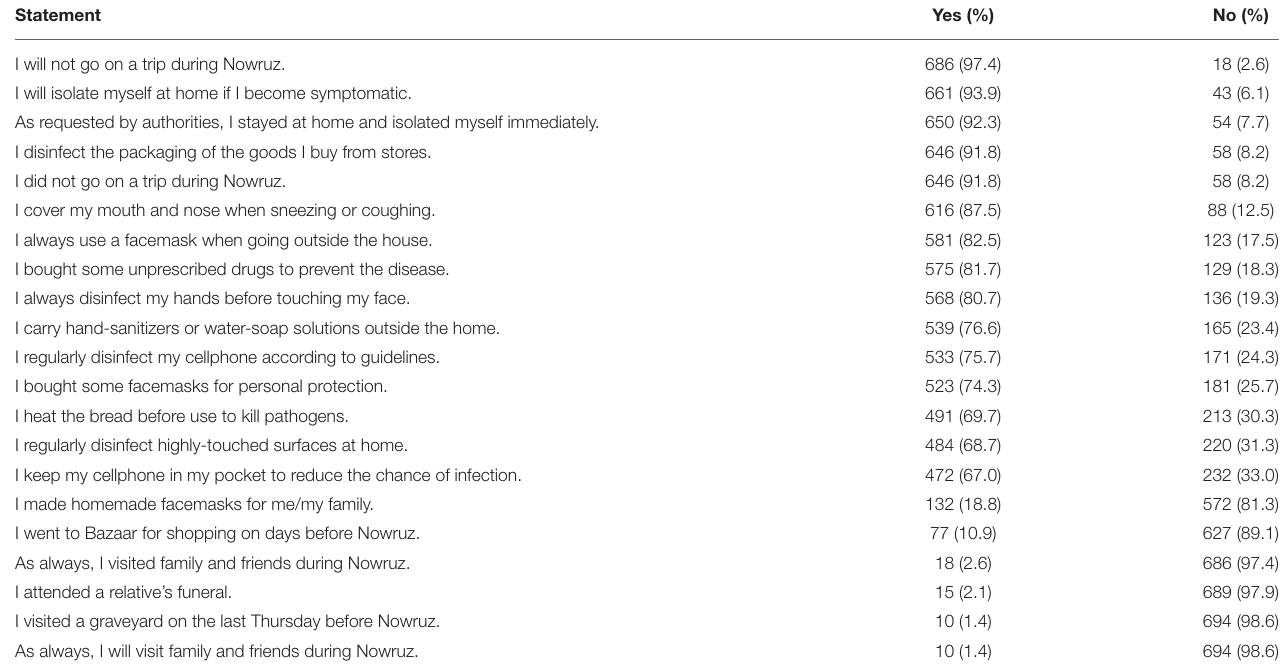
TABLE 6 | General statements regarding safety practices of students about